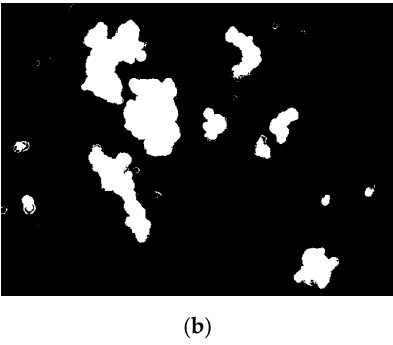
Figure 1. ( a ) Image of agglomerated milk powder particles; ( b ) Particle identification processed by MATLAB.